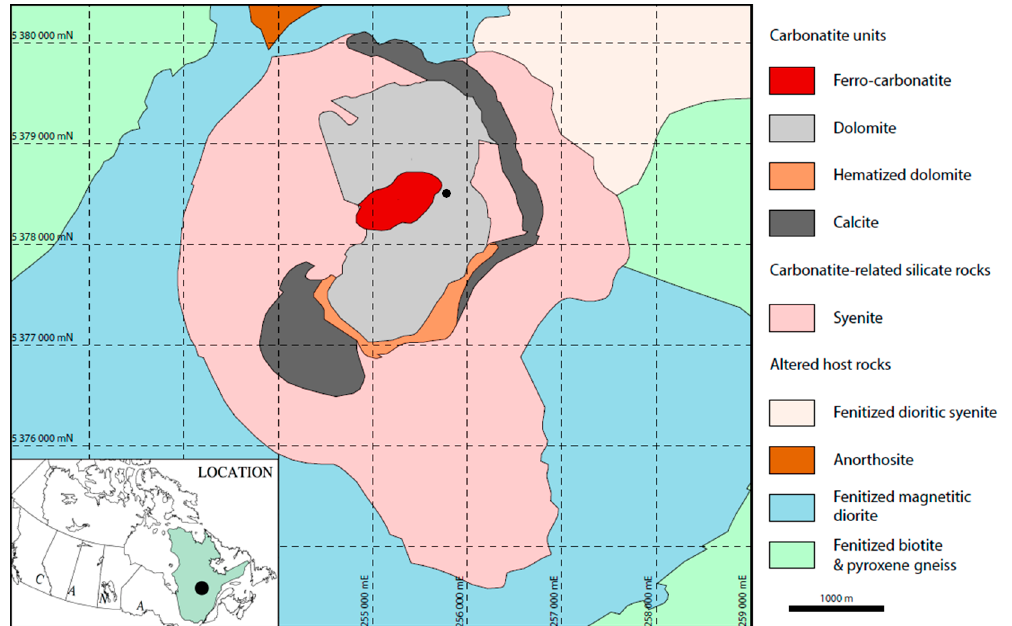
Figure 2. Geological map of the Saint-Honoré alkaline complex (below the Ordovician limestone). The location of deepest drill core used for geochemistry is localized by the black dot in the center of the ferro-carbonatite. The figure is modified from Niobec Inc. (Guillaume Matton, personal communication 2018) (UTM NAD 83 projection, Zone 19N). Table 1. Representative analyses of different units within the Saint-Honoré complex (from [40]). Nepheline Syenite Alkaline Syenite Ca-Carbonatite Mg-Carbonatite Fe-Carbonatite